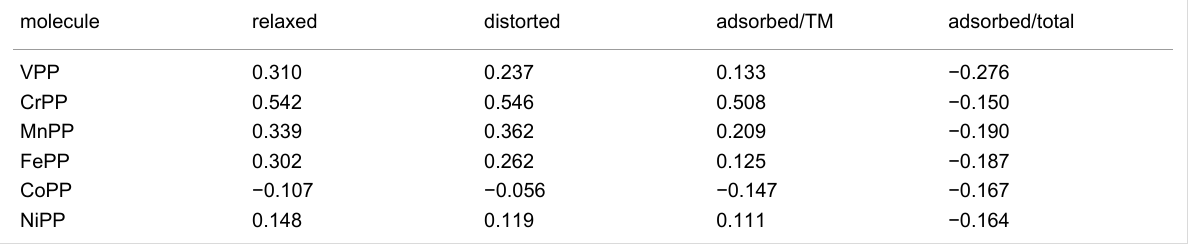
Table 2: Voronoi populations, expressed in | e | for the central TM atom for all TMPP molecules. From left to right: single molecule at relaxed geometry; single molecule at the adsorption geometry; molecule adsorbed at the bridge site and total population over the entire adsorbed molecule. molecule